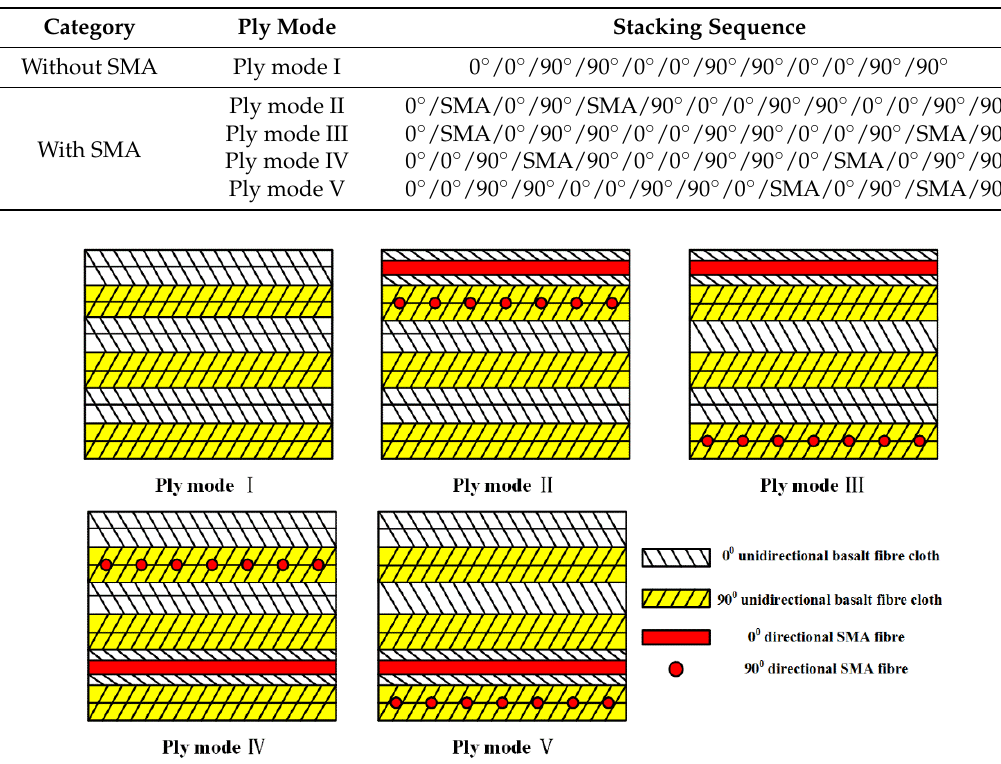
Figure 2. The sketches of composites with different ply modes.